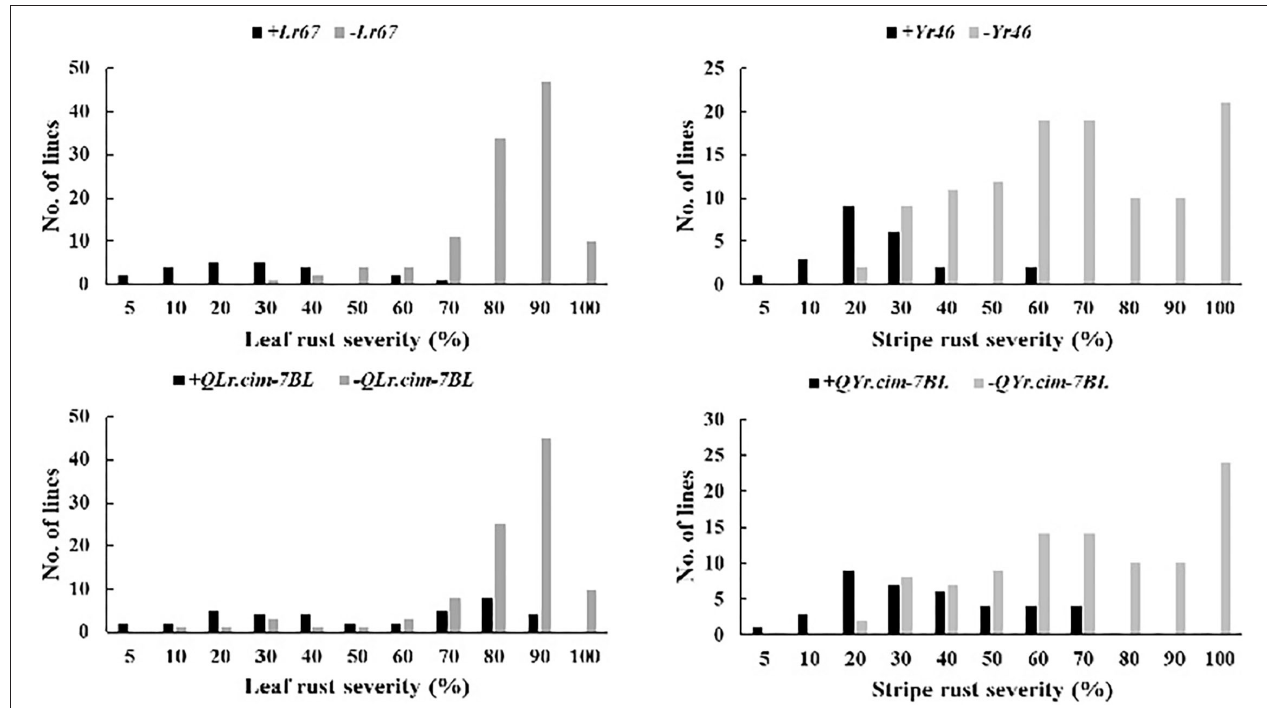
FIGURE 3 | Comparison of KU3067/Apav BILs for mean MDS of LR and YR in the presence or absence of resistance allele for Lr67/Yr46 and QLr.cim-7BL/QYr.cim-7BL in field trials.